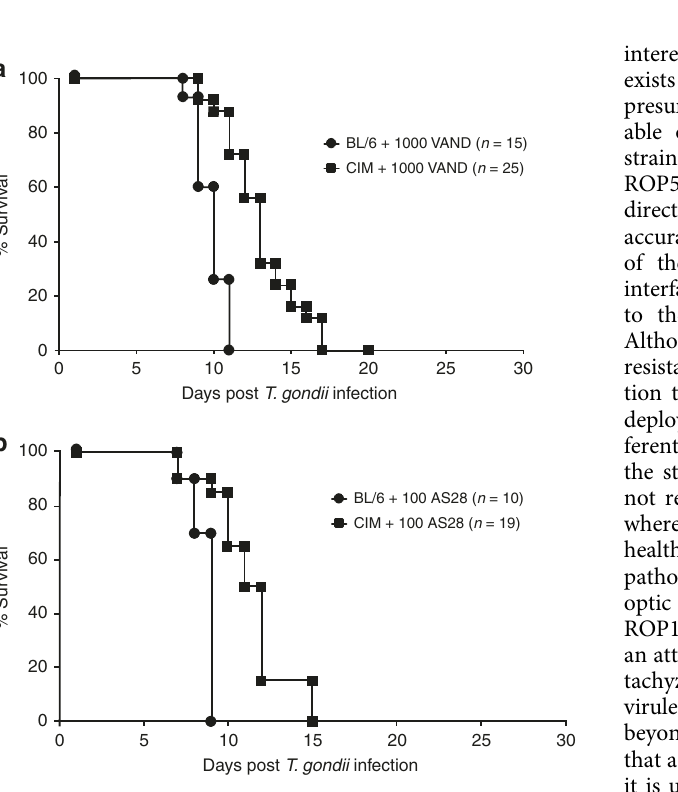
Fig. 5 South American T. gondii VAND and AS28 evade growth restriction in CIM mice. CIM wild-type (wt) ( a , n = 25; b , n = 19) and C57BL/6 ( a , n = 15; b , n = 10) mice were infected by intraperitoneal injection of 1000 T. gondii VAND ( a ) or 100 AS28 ( b ) strain parasites and survival monitored for 15 – 20 days. Data shown are combined from three ( a ) or two ( b